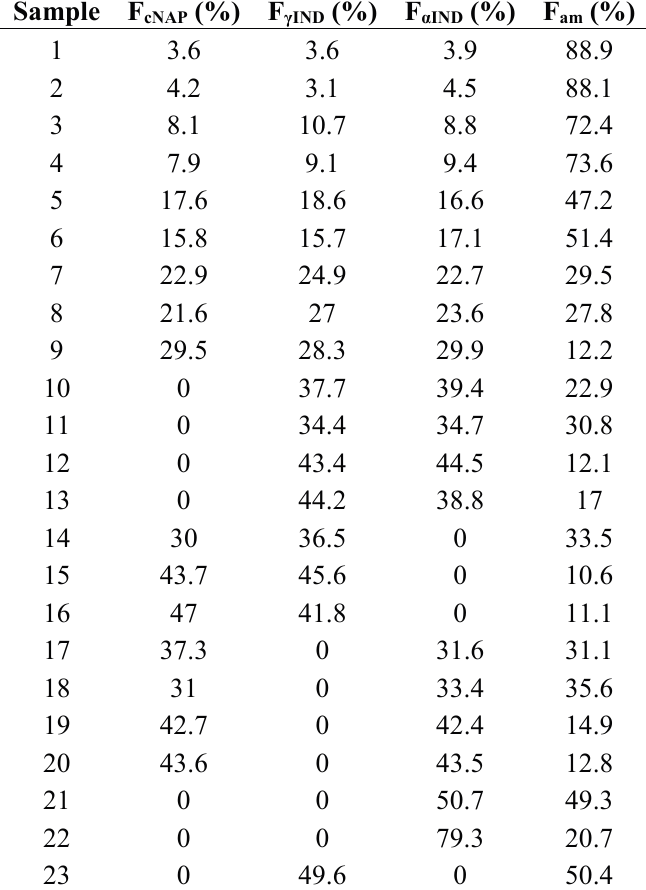
Table A1. Molar compositions of the 52 prepared calibration